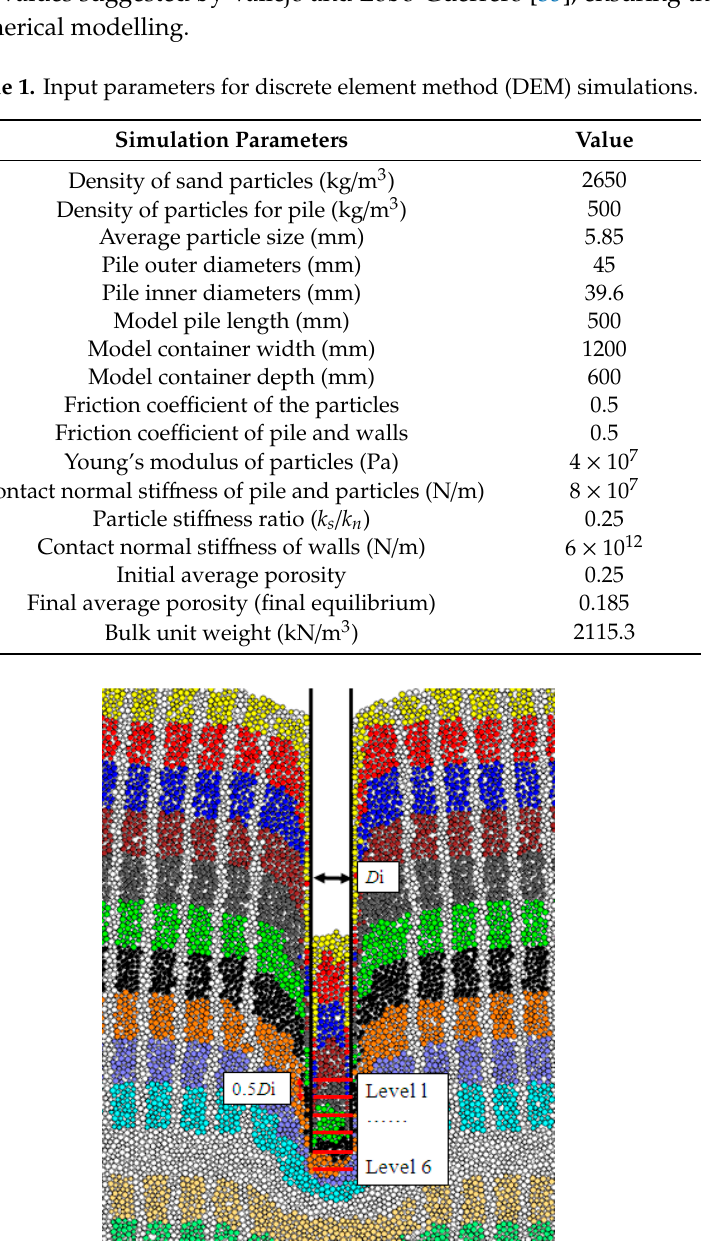
Figure 13. View of pile-soil system just after installation.